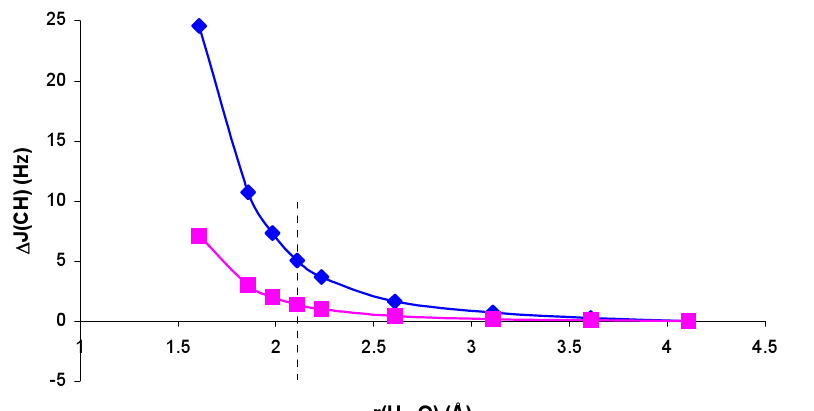
Figure 3. Geometric change in 1 J(CH) for the NCH molecule with the complex geometry, ∆ J G , with respect to 1 J(CH) for the isolated NCH molecule, as a function of the H...O distance, r(H...O). - (cid:88) - ∆ J G (RPA), - (cid:81) - ∆ J G (SOPPA). The dotted line indicates the equilibrium distance.